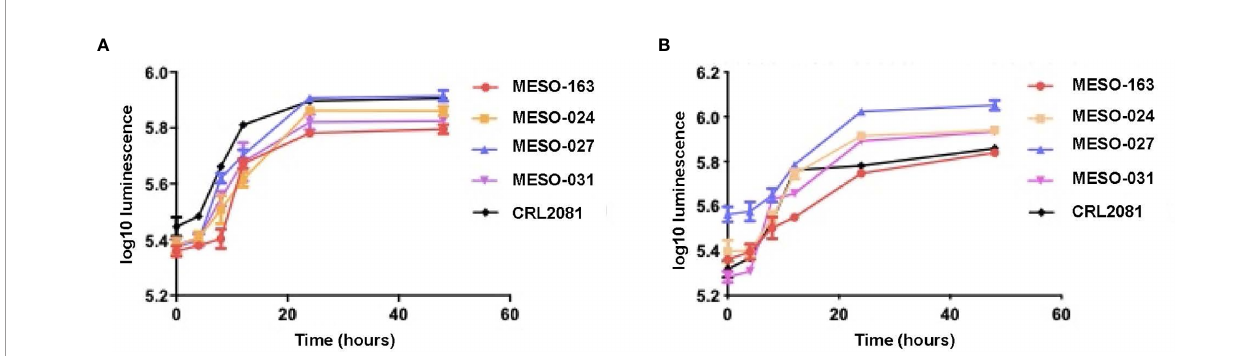
FIGURE 2 | The growth curves with mean and 95% con fi dence intervals for each time point, obtained after 20,000 MPM cells per well (96-well plate) were seeded in starvation medium for 12 hours, then starvation medium was replaced with (A) exudate MPM MPE fl uid and (B) transudate MPE fl uid from a patient with lung adenocarcinoma MPE (right sided graph). Cell viability was measured at 4, 8, 12, 24 and 48 hours using CellTiter-Glo ® . Cell cultures: MESO-163 (epithelioid MPM),